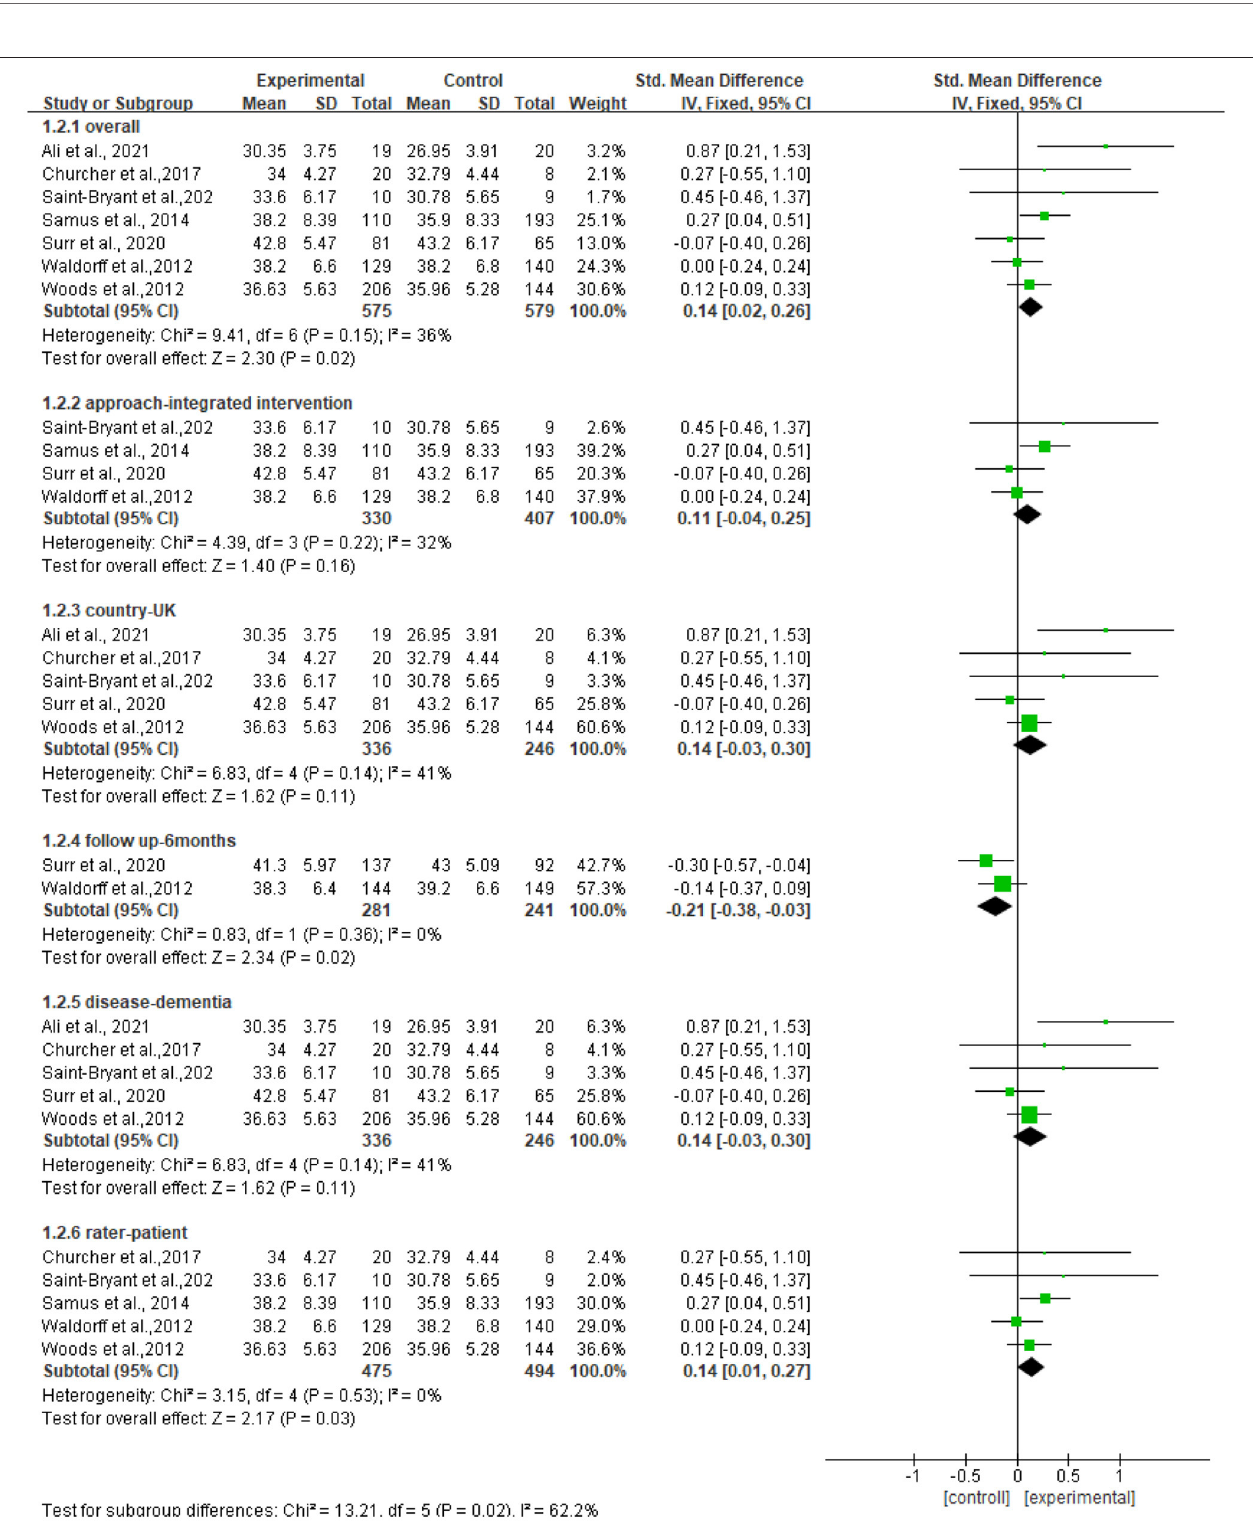
FIGURE 4 | Subgroup analyses of the intervention group vs. the control group on QOL-AD rating scores.